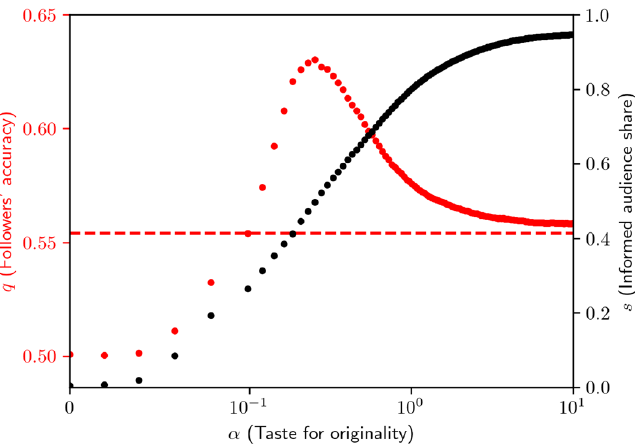
Figure 4. Impact of α on I audience share s and followers accuracy q (with the asymptotic value of q as a dashed line when s → 1